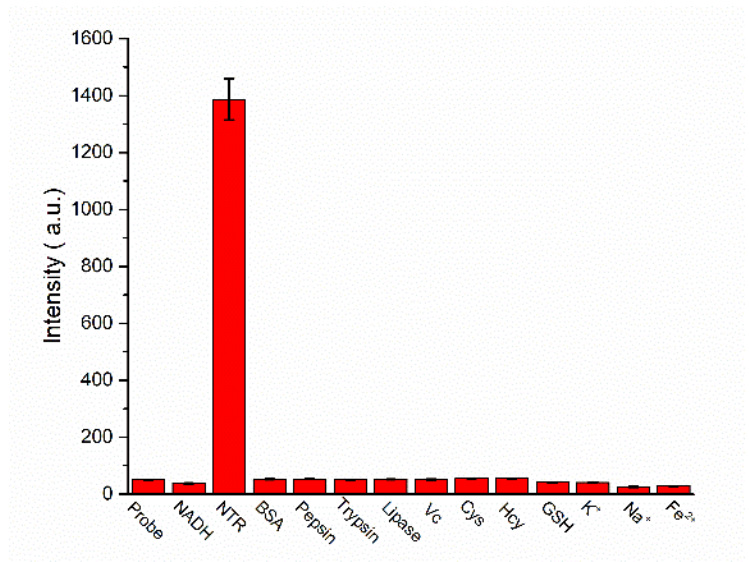
Figure 2. Fluorescence response of Py-SiRh-NTR toward various biologically relevant species. NTR (15 μg/mL), BSA, ABM, Trypsin, Lipase (20 μg/mL) and other biologically relevant species (100 μM).